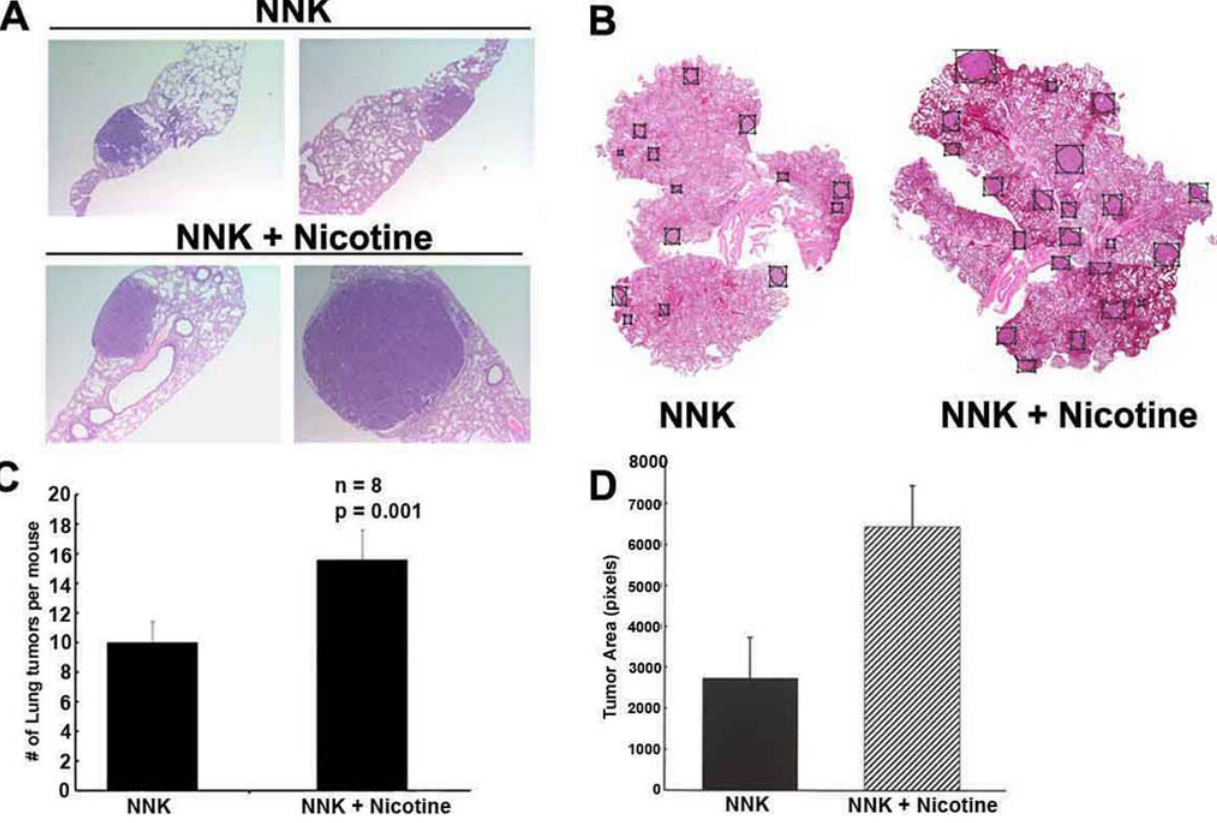
Figure 3. Nicotine increases number and size of NNK induced lung tumors. (A) H&E staining of transverse sectioning of lungs (B) Representative scanned images of H&E stained coronal lung sections, tumors are outlined by boxes. Images were scanned at 20 6 magnification. (C) Nicotine increases the average number of lung tumors per mouse, p =0.01, n =8. (D) Nicotine increased tumor size significantly in A/J mice.